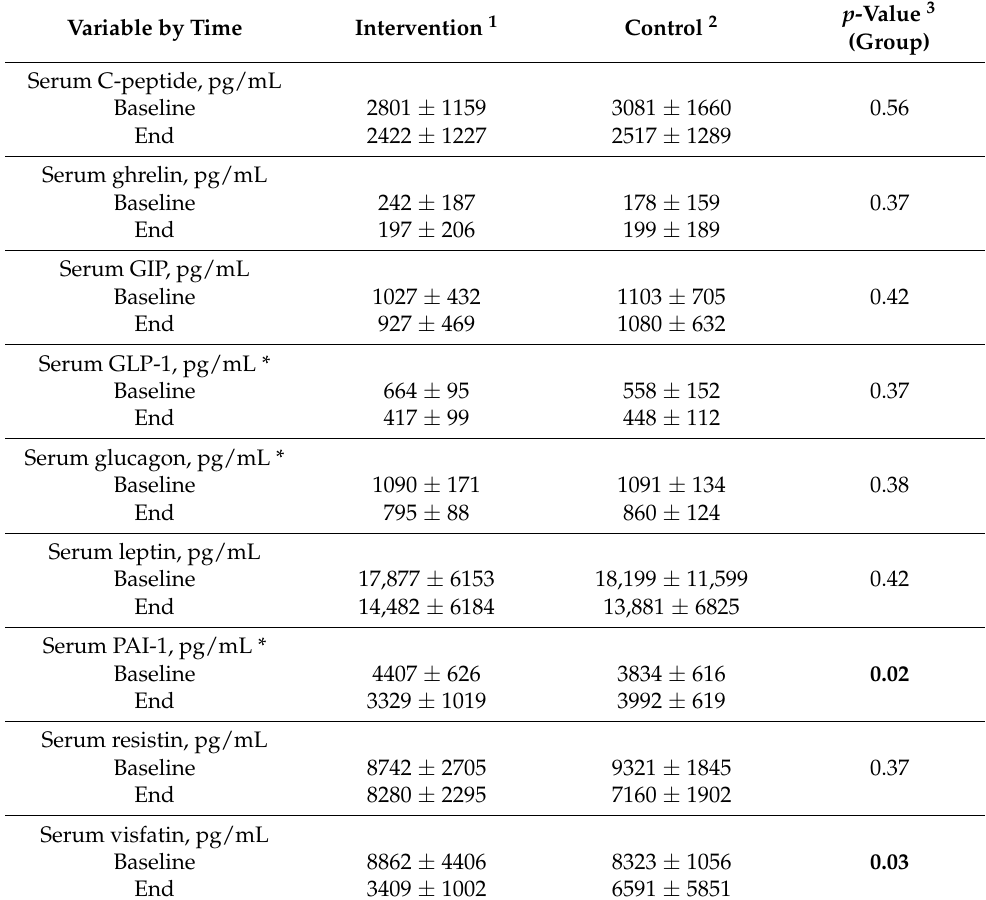
Table 2. Serum adipokines and hormonal markers in women with obesity and at risk for gestational diabetes in dietary intervention vs. control group for a period of 18 gestation weeks. p -Value 3 Variable by Time Intervention 1 Control 2 (Group) Serum C-peptide, pg/mL Baseline 2801 ± 1159 3081 ± 1660 0.56 End 2422 ± 1227 242 ± 187